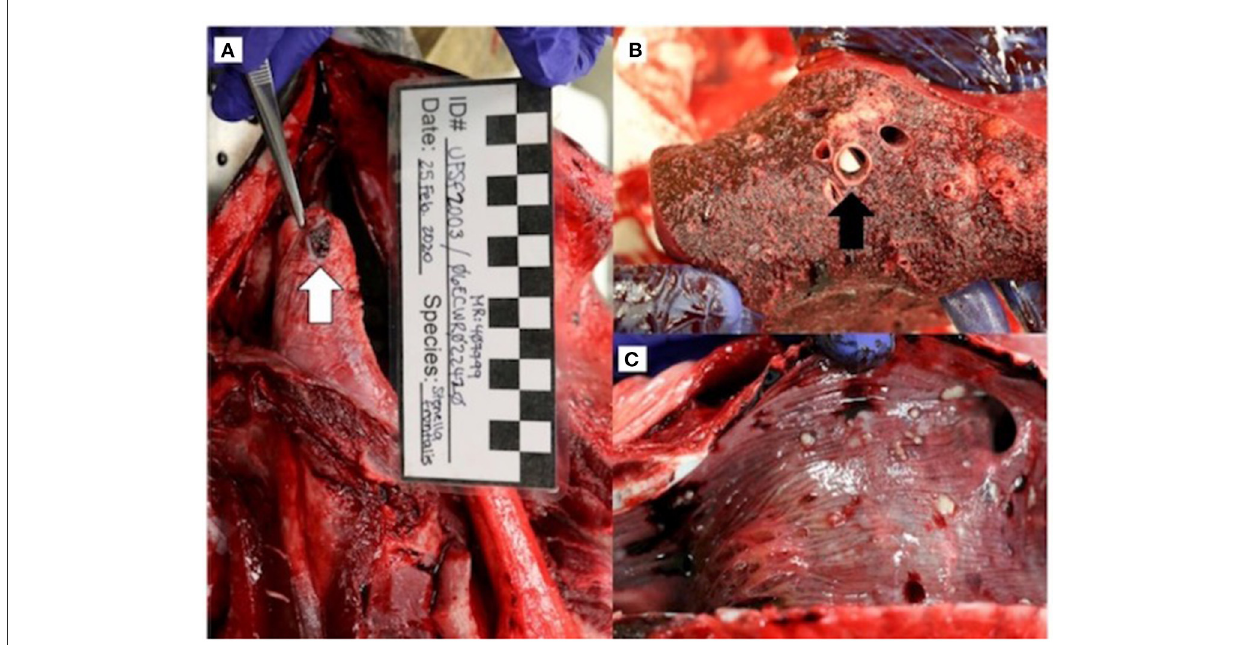
FIGURE2 Gross necropsy findings in an adult male Stenella frontalis included a 1.0 x 0.8cm ulcerated lesion (white arrow) on the ventral aspect of the tongue (A) , lungs with multifocal to coalescing white raised nodules (B) with necrotic debris within bronchi (black arrow), and thick mucus and 1 to 4mm free floating white debris in the anterior trachea (C)